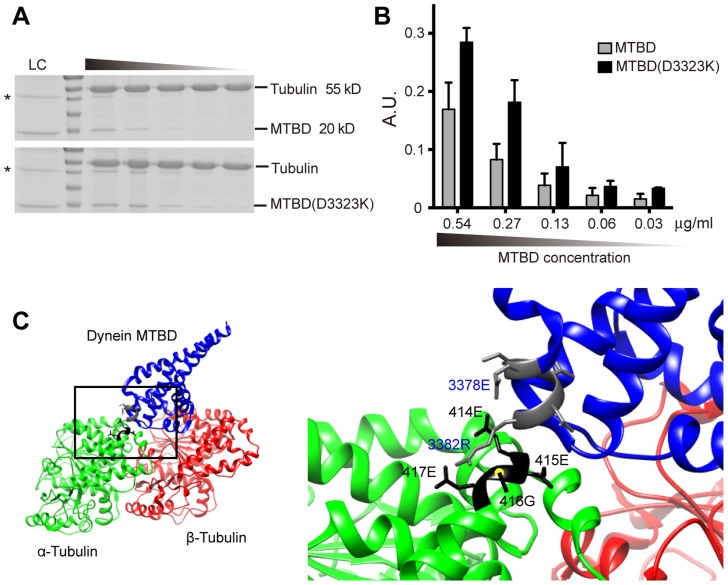
In vitro DHC-1 MTBD sedimentation assay and model of dynein MTBD-tubulin dimer interaction.(A) SDS-PAGE gel image stained with Coomassie blue for microtubule sedimentation using purified wild-type MTBD or MTBD(D3323K) of DHC-1. Lanes from left to right represent serial 2-fold dilution of MTBD loading, with concentrations indicated. LC, loading control. (B) Quantification (mean ± S.E.M.) of MTBD co-sedimented with microtubules. Data were averaged from three independent experiments. (C) The structure of the dynein microtubule-binding domain (MTBD) complexed with the tubulin dimer. Data from Protein Data Bank (PDB#3J1T) were processed by UCSF Chimera software. The interaction surface between the H12 of the α-tubulin and the dynein MTBD was highlighted in the bottom panel. Residues of the α-tubulin were labled in black, and those from the dynein MTBD were labeled in blue. An intramolecular salt bridge was suggested to form between E3378 and R3382 of the dynein MTBD when dynein is at some distance from the tubulin surface. Upon approaching the tubulin dimer, negative charges of the H12 of tubulin dimers were hypothesized to break the MTBD intramolecular salt bridge and foster the interaction between the MTBD and the tubulin dimer [12].